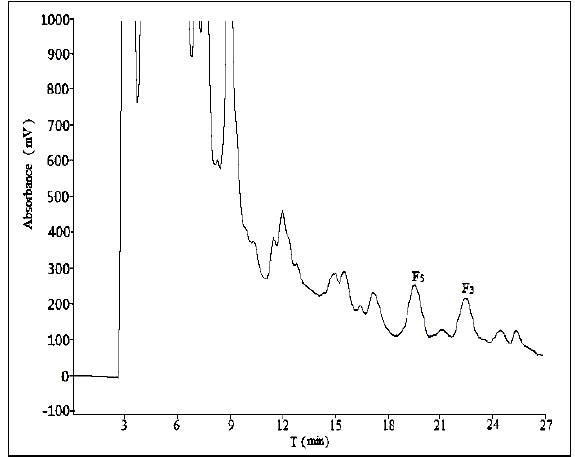
Figure 4. The semi-preparative chromatogram of CEFBPG with the mobile phase of acetonitrile:water:phosphoric acid (28:71:1) at room temperature and a flow rate of 10 mL/min.